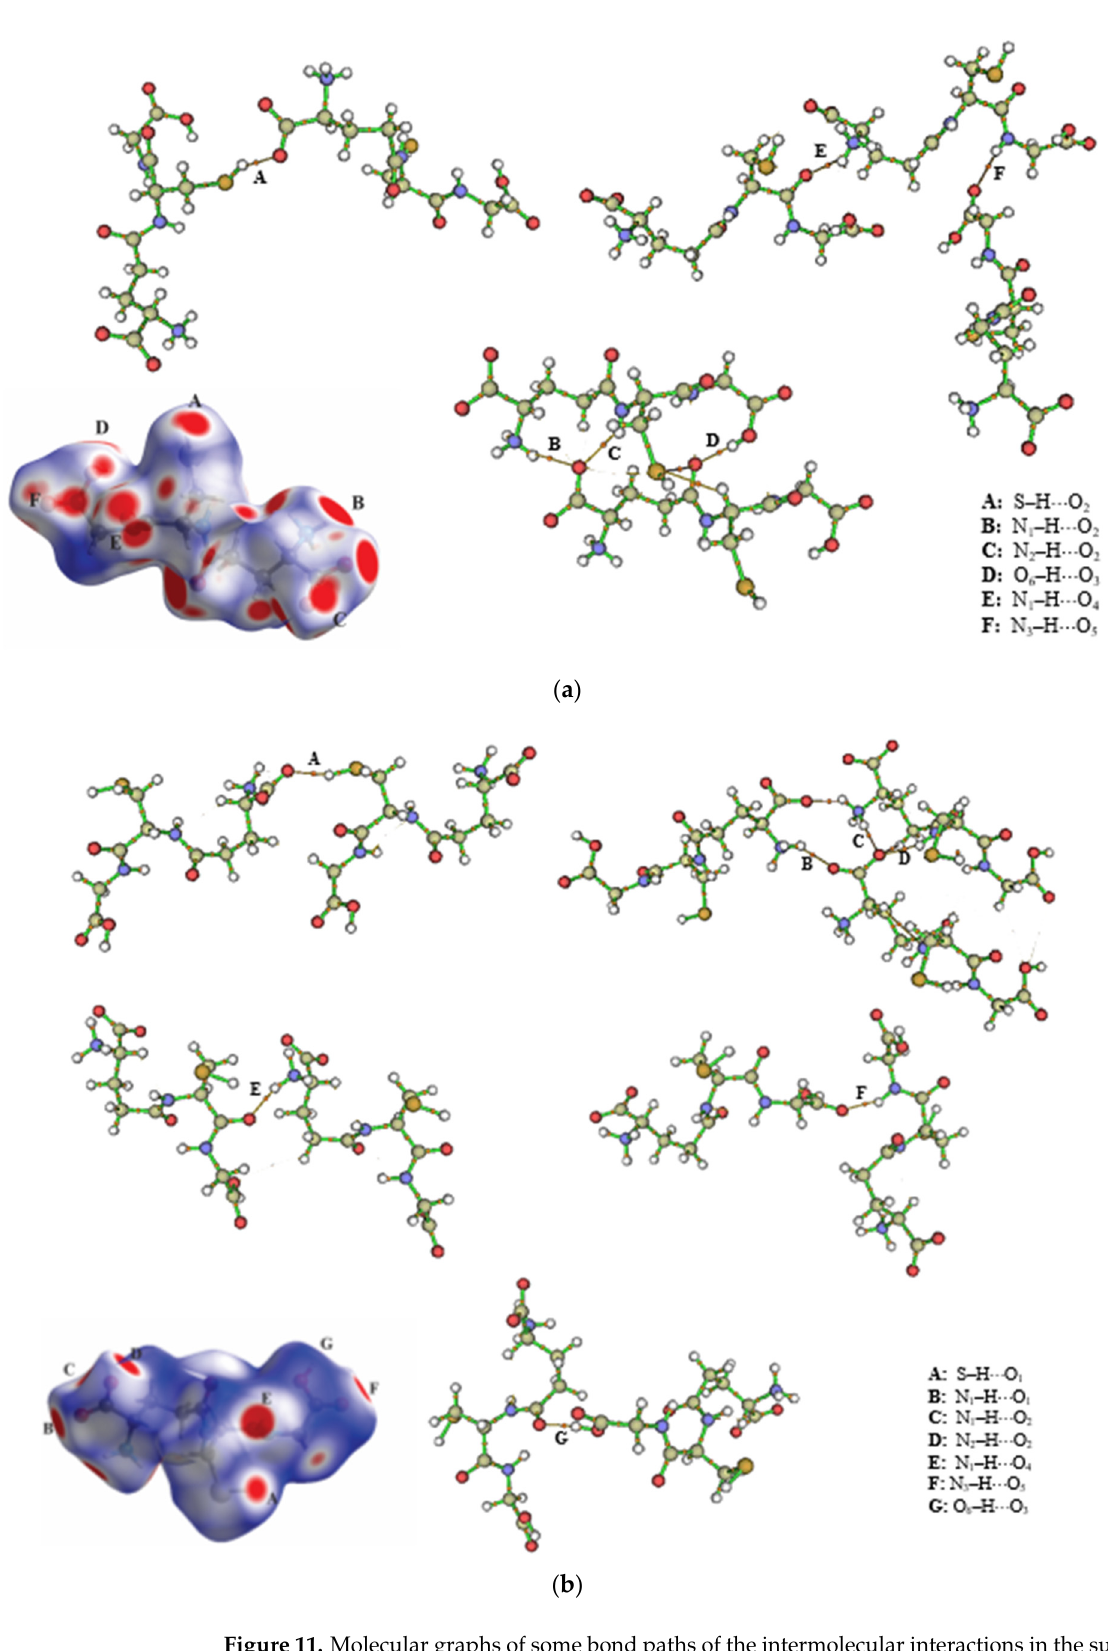
Figure 11. Molecular graphs of some bond paths of the intermolecular interactions in the supramolecular arrangements of the ( a ) GSHA and ( b ) GSHB polymorphs.